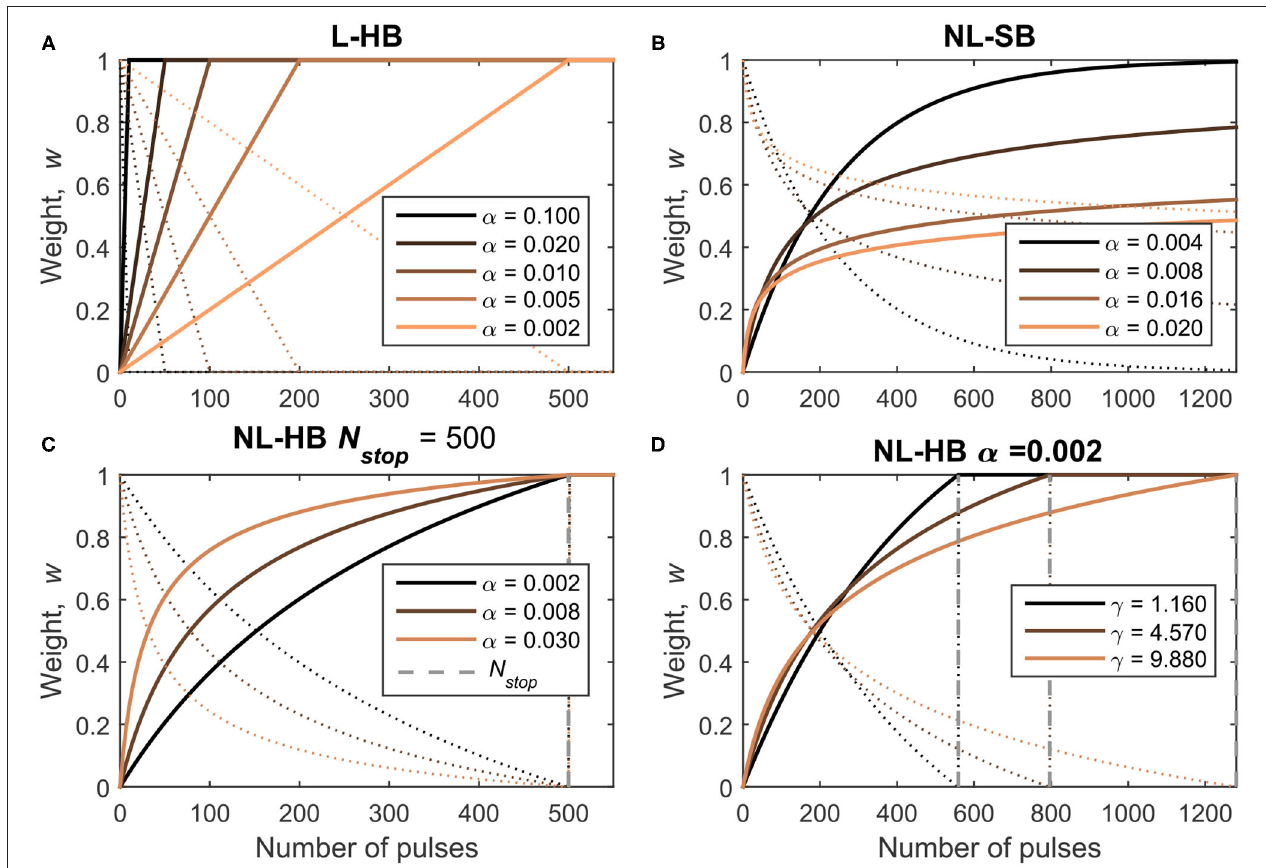
FIGURE 2 | Investigated dynamics: (A) Linear Hard-Bound (L-HB); (B) Non-Linear Soft-Bound (NL-SB) and (C,D) Non-Linear Hard-Bound (NL-HB). Dynamics are plotted as a function of the number of pulses for potentiation and depression operations (straight and dotted lines, respectively). The various dynamics cases are defined in Table 1